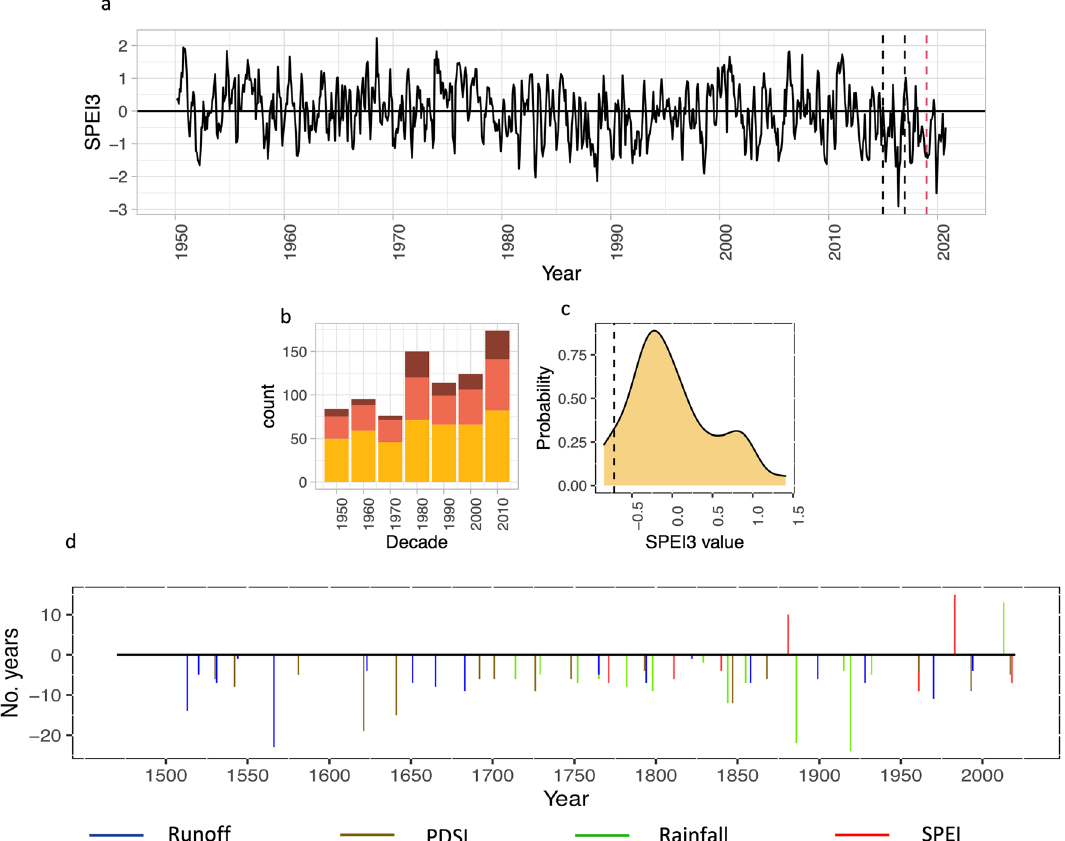
Figure 4. Hydroclimate and native tree deaths. ( a ) Monthly mSPEI3 values for the monsoonal north (for the box — 17.75S 128.25E–10.25S–142.75E) from 1950 to 2020 (data source: https:// spei. csic. es/ datab ase. html). Black dotted lines show the period from January 2015 to December 2016. Lowest mSPEI3 value recorded in June 2016. Red dotted line shows start of 2019. ( b ) Number of months per decade for which mSPEI3 < 0 (yellow), mSPEI3 < − 0.5 (coral), mSPEI3 < − 1 (dark red). ( c ) Distribution of 6-year non-overlapping averages of the March–May SPEI3 (reconstruction + instrumental). Dashed line shows the average SPEI3 value for the 2014–2019 period. ( d ) Runs of wet and dry years consistent with criteria described in main text according to the four different hydroclimate indices. A run of dry years is defined as at least 4 of 5 consecutive years with a value of − 0.5 s below the mean for the 1961–90 reference period. Longer dry periods may include up to two non-event years. Wet events include at least 10 wet years (+ 0.5 s) over a period of no more than 12 years. Y-axis indicates number of years events persisted. Negative values indicate extended dry events, positive values reflect extended wet events according to the criteria applied